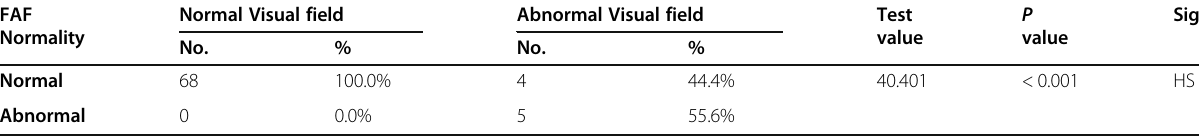
Table 3 Comparison between the 10 – 12 visual field and FAF FAF Normal Visual field Normality